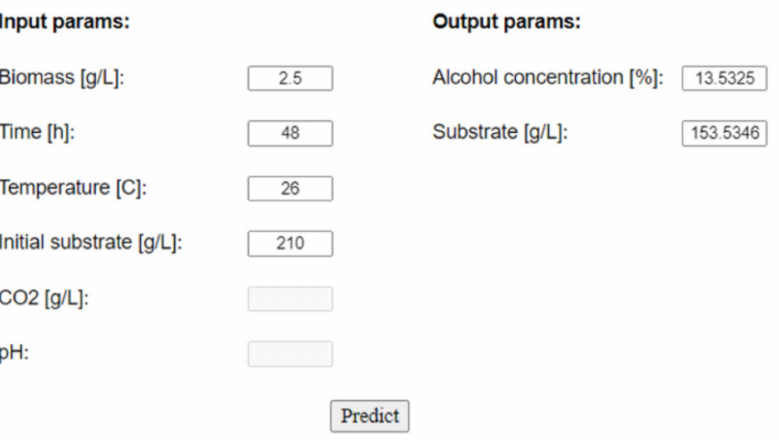
Figure 7. The output parameter generation, based on the prediction